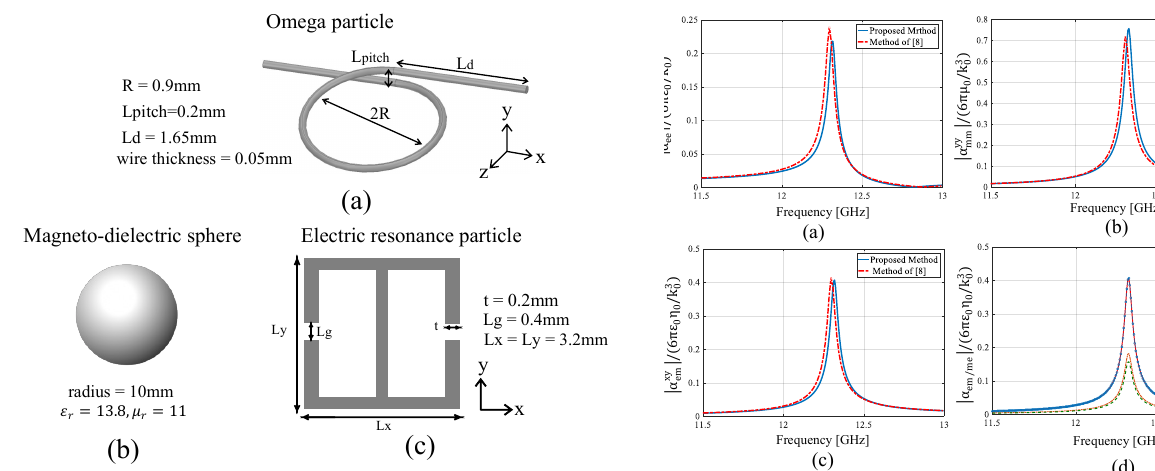
Figure 3: Normalized dominant polarizability